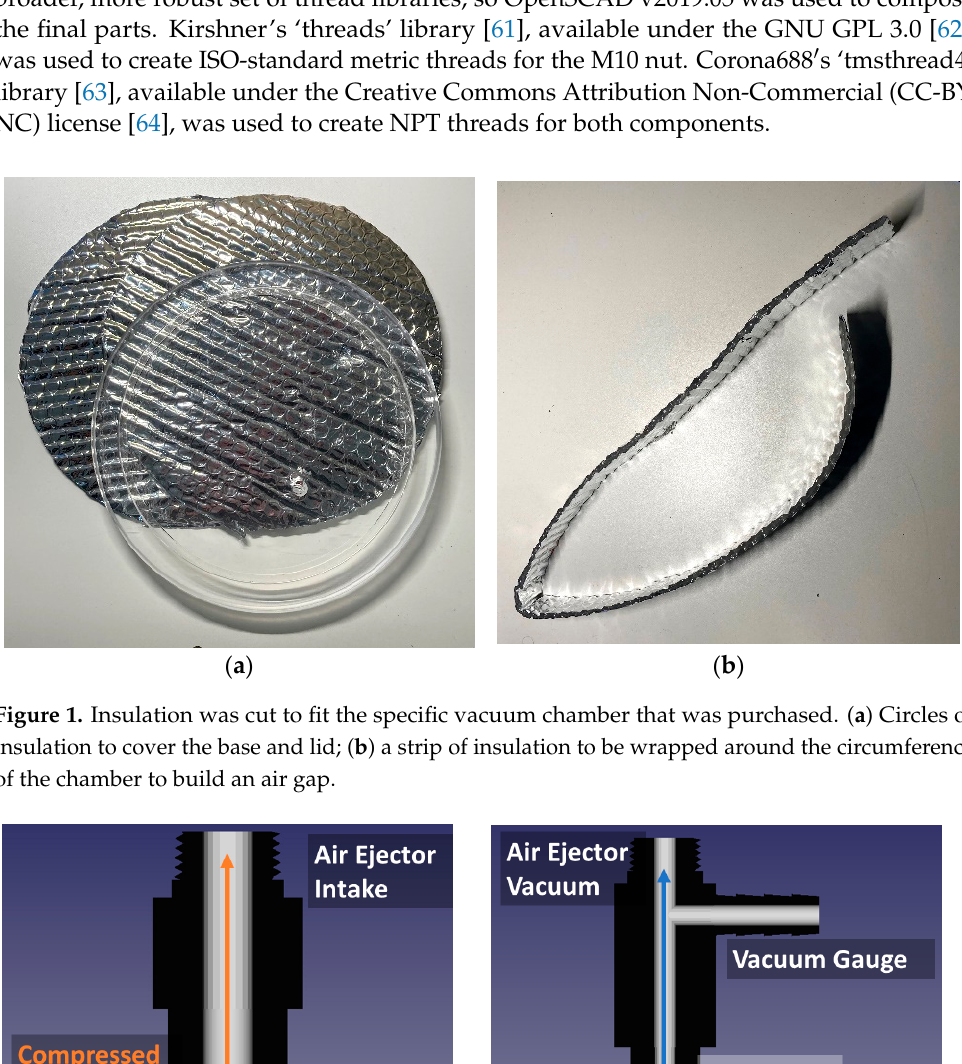
Table 1. Print Settings for PLA. Property